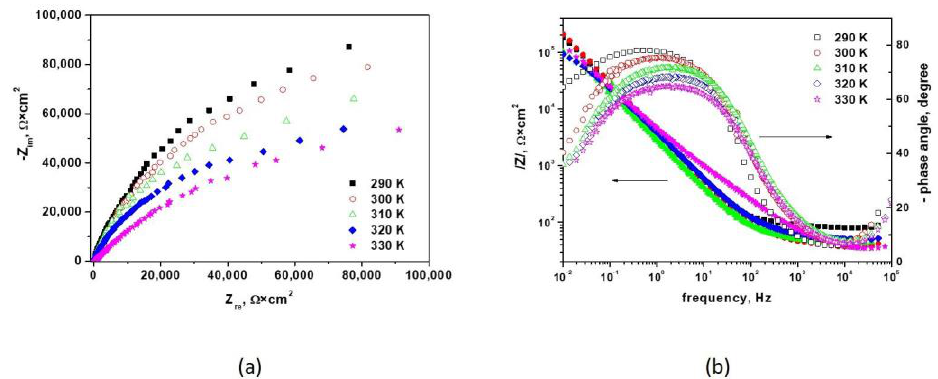
Figure 4. Nyquist ( a ) and Bode ( b ) diagrams for CoCr alloy immersed in artificial saliva at different temperatures.